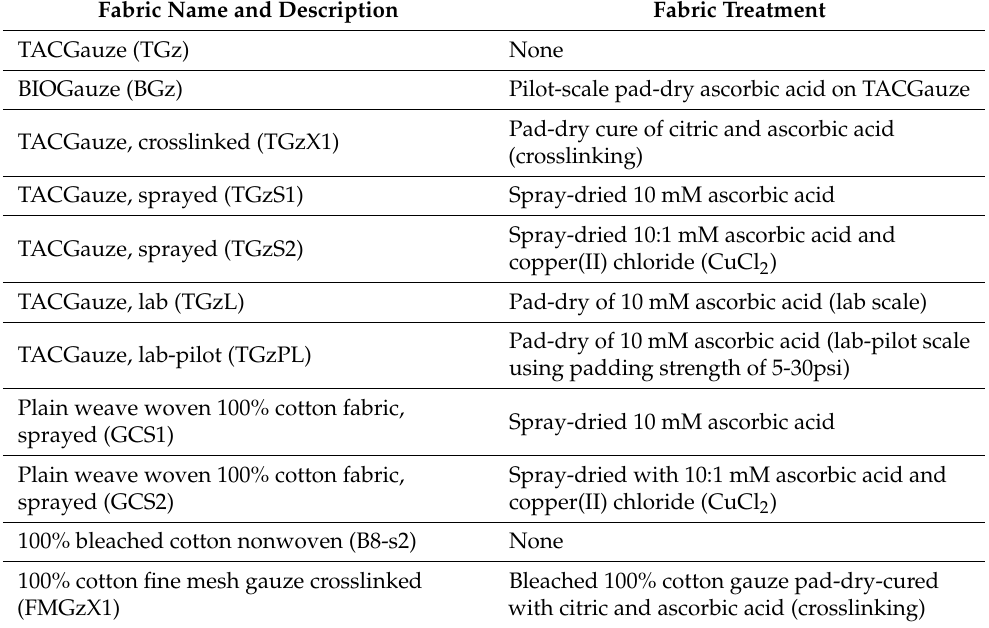
Table 1. Description of fabrics. Fabric Name and